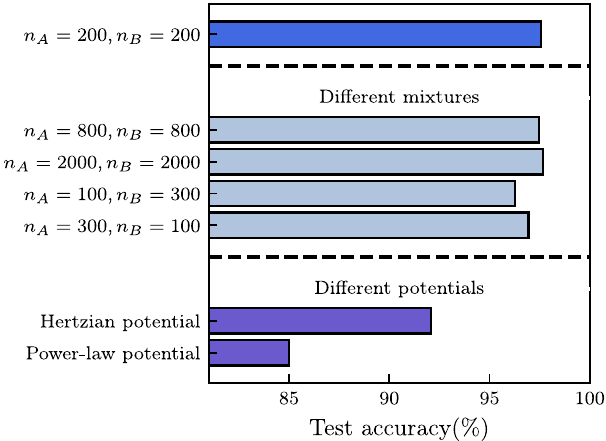
Fig. 3 Robustness of force chain prediction accuracy for a variety of physical scenarios. A graph neural network trained on a data set with a harmonic potential and number of particles (top) can also accurately predict force chains for con fi gurations with different system size (number of particles), different ratio of mixture components or with a different interaction potential. All results shown here are obtained at packing fraction ϕ =